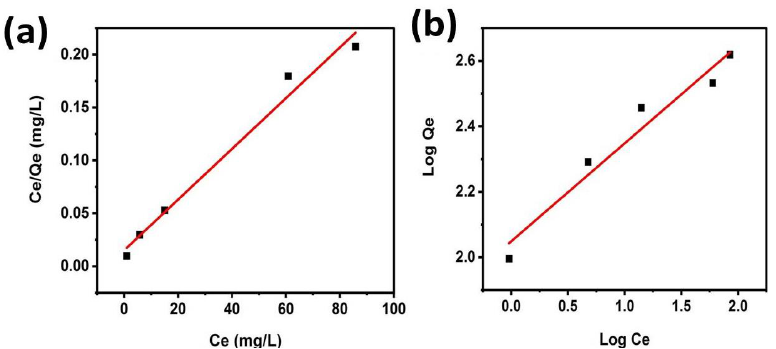
Figure 6. Langmuir graph ( a ) and Freundlich graph ( b ) MB adsorption on WHB/CA at pH = 5, 0.1 g biochar, T = 25 °C, and initial concentration of 300 mg/L.